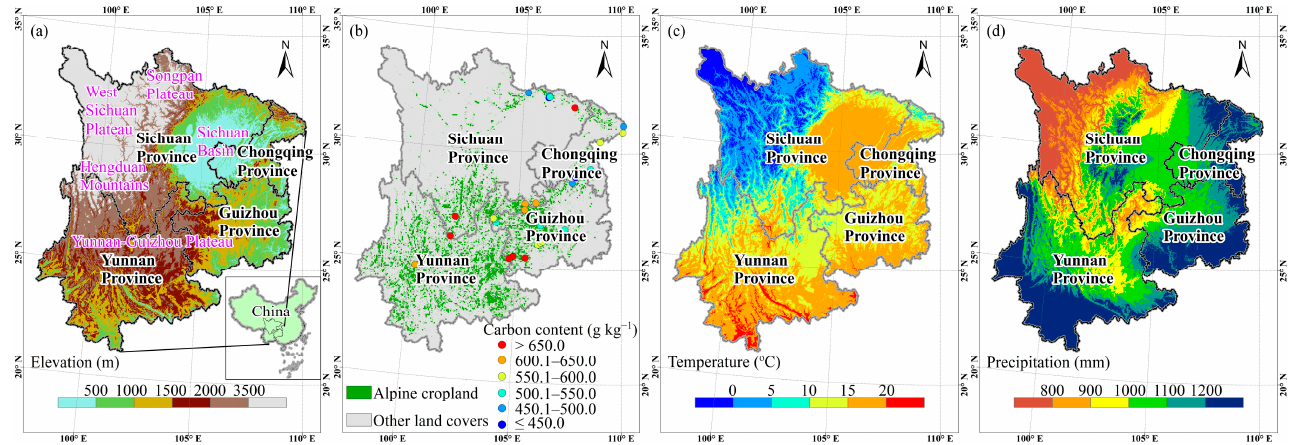
Figure 1. Spatial patterns of elevation ( a ), cropland distribution ( b ), annual mean temperature ( c ), and annual total precipitation ( d ) in the alpine region of the southwest China. ( b ) Alpine cropland distributed above 1000 m ASL and locations of field survey sites. Details of survey methods can be found in Section 2.2.